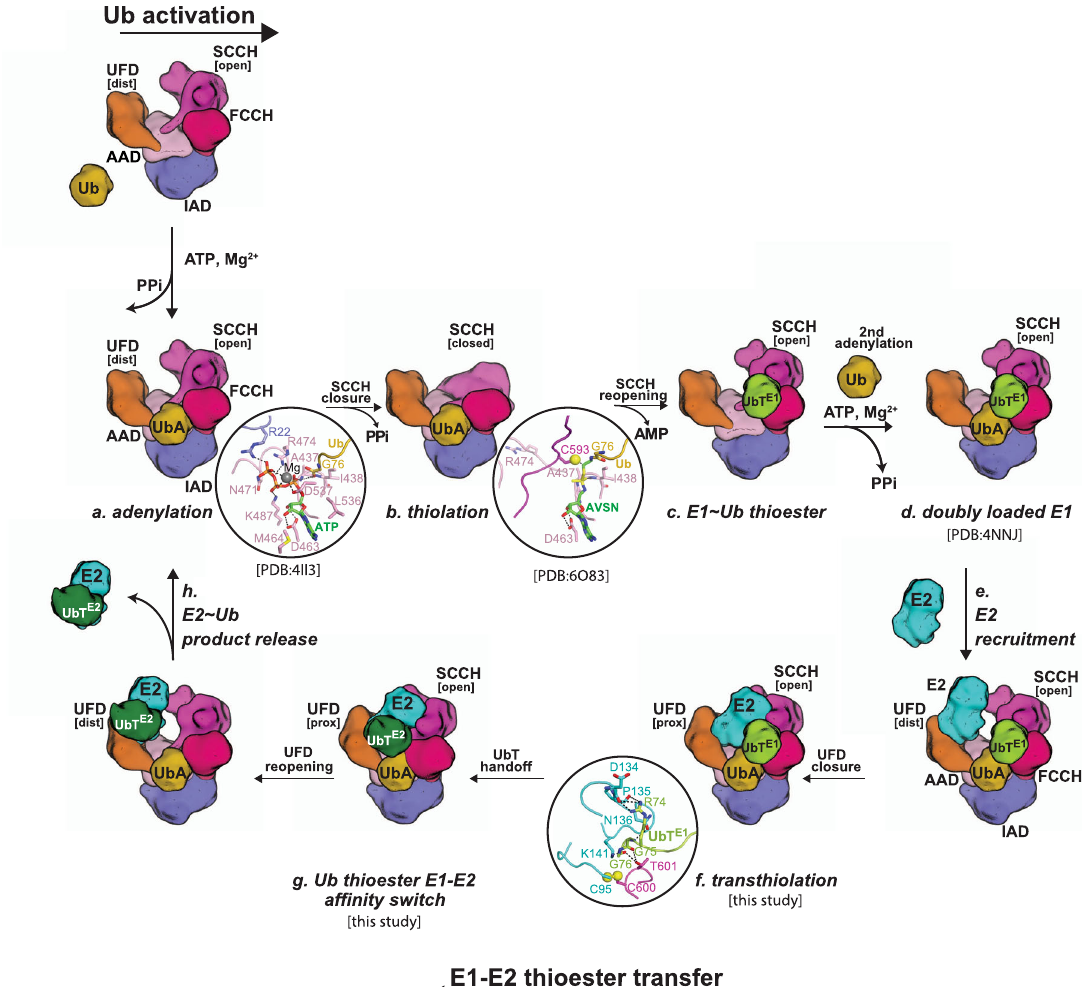
Fig. 6 Model of E1 – E2 thioester transfer reaction cycle. a Ub E1 catalyzes adenylation of the Ub C-terminal Gly76 in the presence of ATP and Mg 2 + b Thiolation with E1 catalytic cysteine through disassemble of adenylation domain and a ~130° rotation of SCCH domain. c E1 – Ub thioesteri fi cation achieved by SCCH relocation to the original open position. d A second Ub binds in the adenylation active site of E1 – Ub to form doubly loaded E1 – Ub(t)/Ub(a). e A E2 is recruited to the UFD with distal con fi guration in doubly loaded E1 – Ub(t)/Ub(a). f UFD rotates from distal to proximal to bring E1 E2 catalytic cysteines into close proximity for E2 – Ub thioester bond formation. g Ub(t) is transferred from E1 catalytic cysteine to E2 catalytic cysteine. h E2 – Ub thioester product is released from E1 with UFD domain in E1 rotating back to the distal conformation to continue the reaction